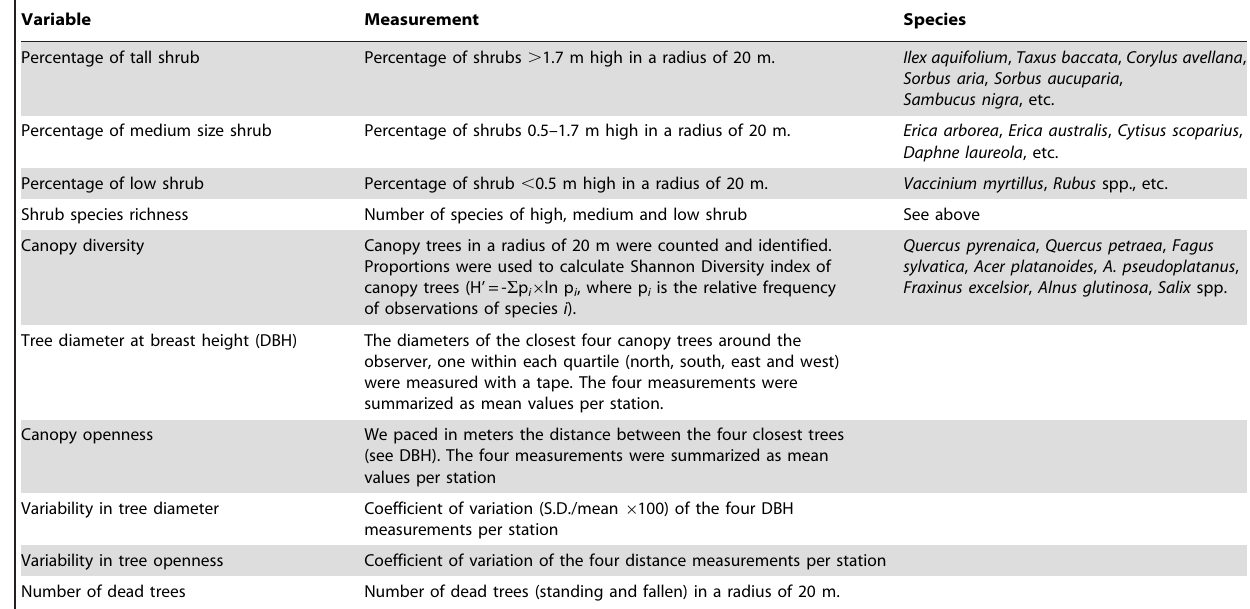
Table 1. List of habitat variables measured per census station.